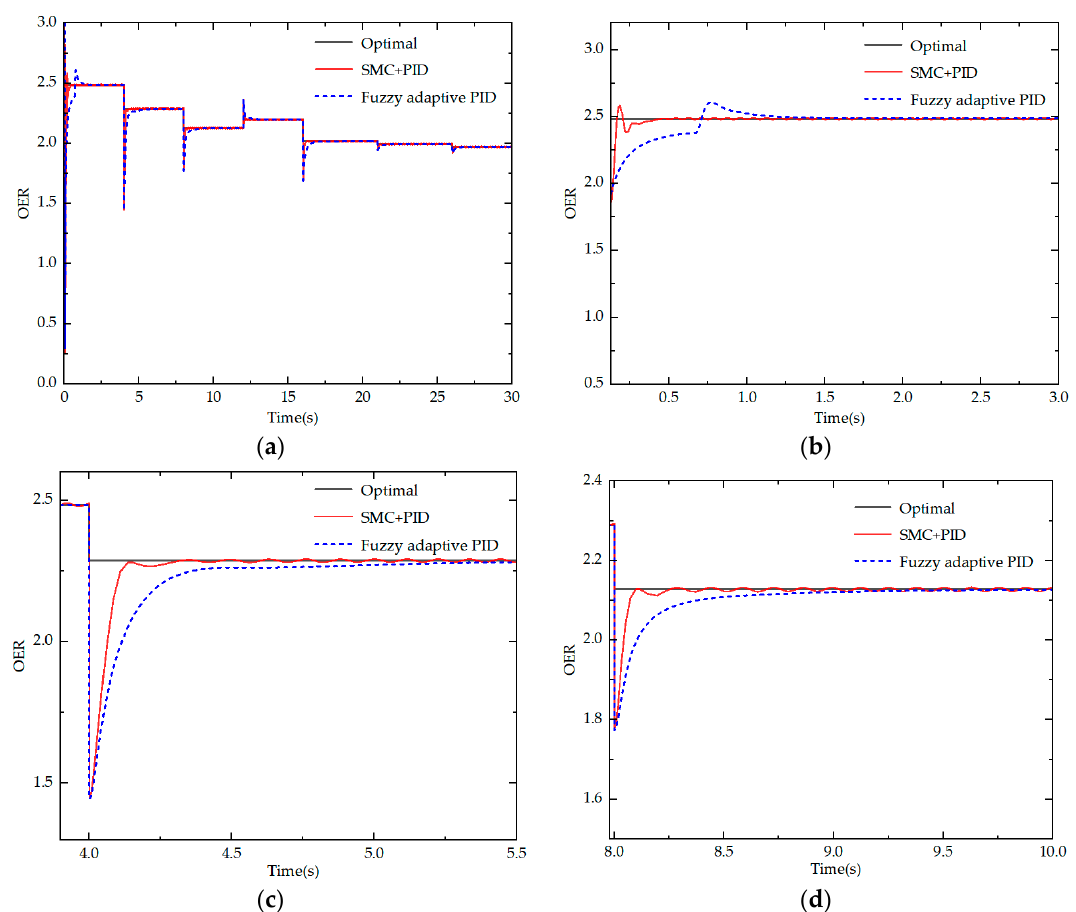
Figure 8. ( a ) OER results of PID and SMC controller cascade control and Fuzzy adaptive PID control under various loads are compared in simulation. ( b – d ) are local magnifications of simulation OER.